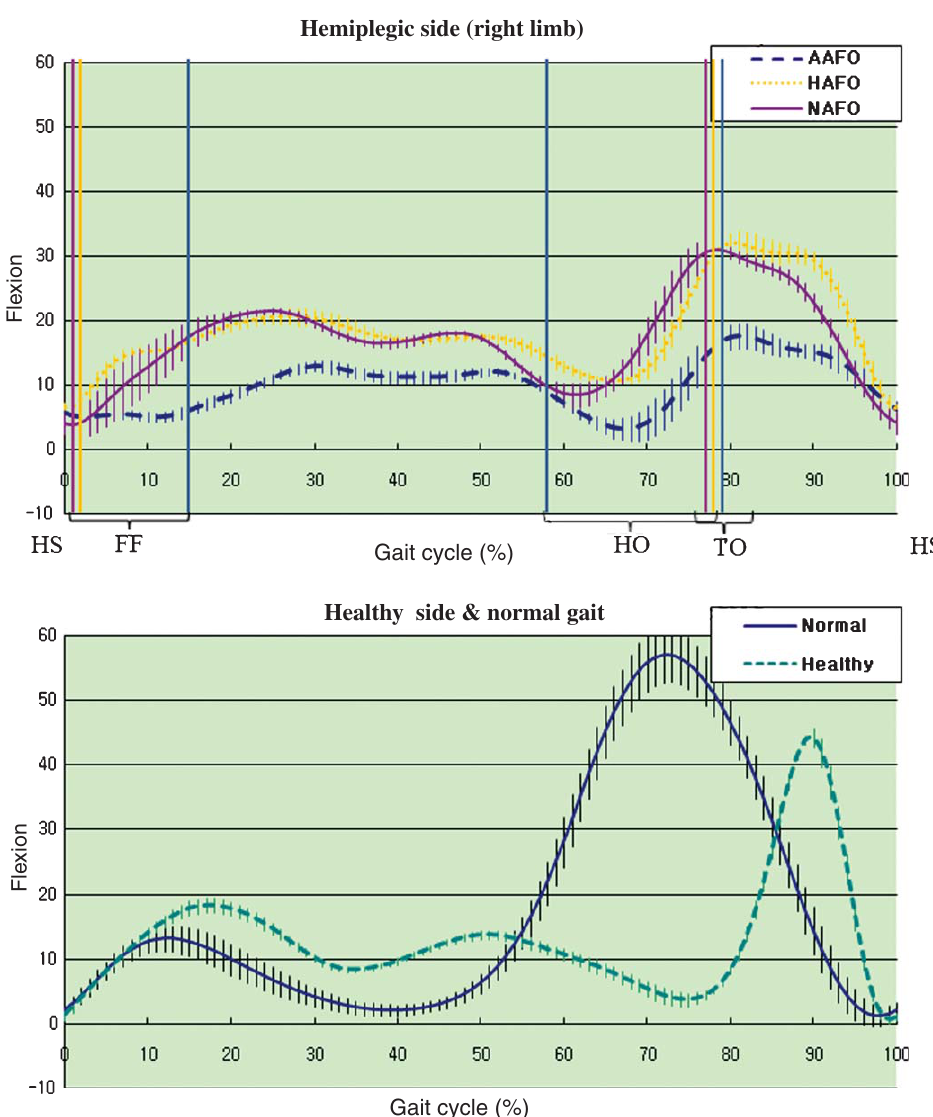
Fig. 10. Knee joint angles during normal, NAFO, HAFO, and AAFO